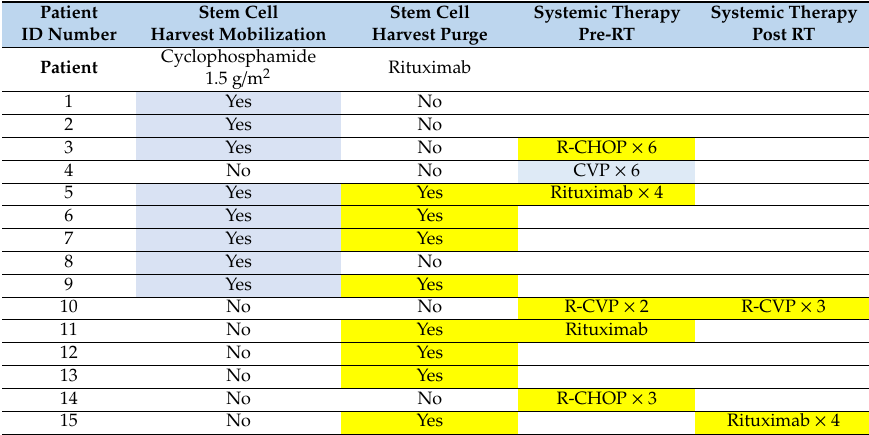
Table 2. Systemic therapies with potential anti-lymphoma e ff ects given as a component of primary treatment or at time of stem cell harvesting. Patients receiving any anti-lymphoma systemic therapy: n = 15 (all shaded cells). Patients receiving any rituximab: n = 11 (yellow shaded cells only). Patient Stem Cell Stem Cell Systemic Therapy Systemic Therapy ID Number Harvest Mobilization Harvest Purge Pre-RT Post RT Cyclophosphamide Patient 1.5 g / m 2